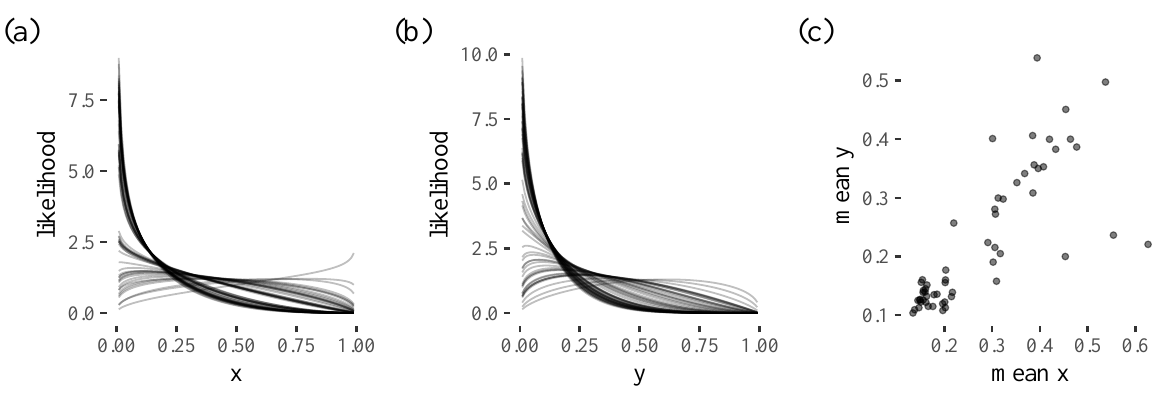
Figure 6. Posterior fits for ( a ) horizontal and ( b ) vertical locations of the initial target selection. Each line represents a different participant. ( c ) A scatter plot showing the x and y posterior means for each participant.